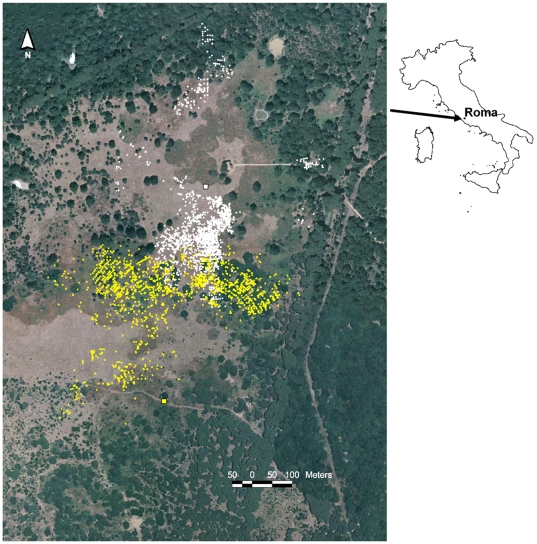
The study site.Squares denote the position of high-seats (#1 in white and #3 in yellow) while dots represent the foraging stations recorded during the study period. Food distribution is patchier in the central zone; deer foraged in meadows (light brownish open areas) or in the bushy areas near the forest's border, but did not use areas where ferns were abundant (brown open areas). No obstacle to animal movement is present in this or surrounding areas.